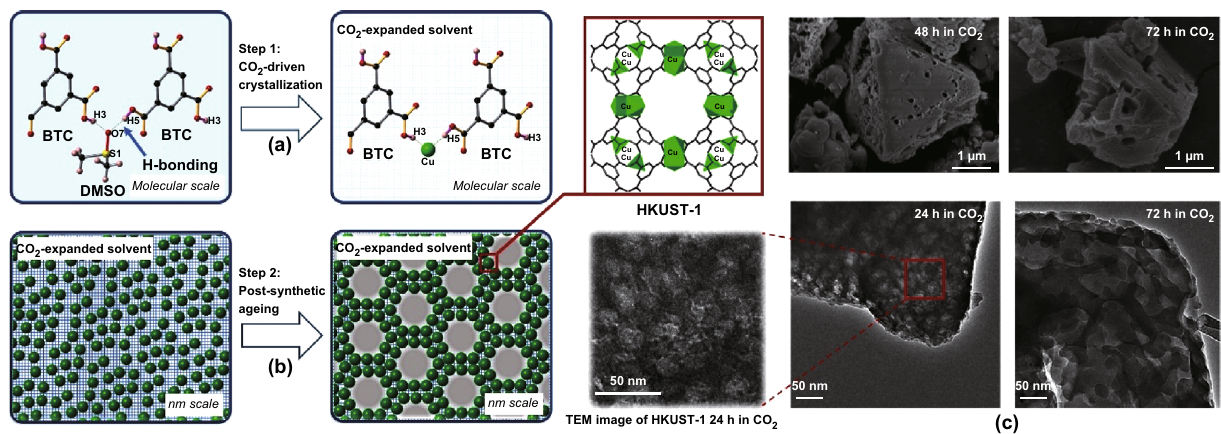
Fig. 18 Schematic illustration for a HKUST-1 crystallisation and b meso/macropore formation in the CO 2 -expanded solvent. c SEM images (top) and TEM images (bottom) of HKUST-1 synthesised using scCO 2 at 75 bar, 40 °C for more than 24 h, showing introduction of intercon- nected macropores. Reprinted with permission from Doan et al. [120]. Copyright CC BY-NC-SA